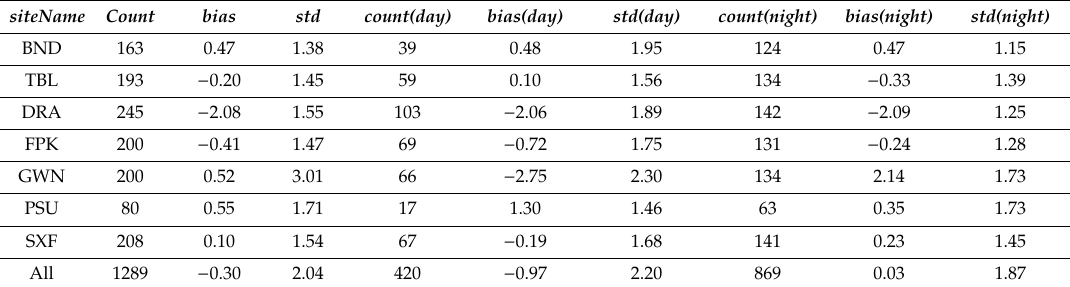
Table 7. N20 VIIRS LST validation results with respect to SURFRAD